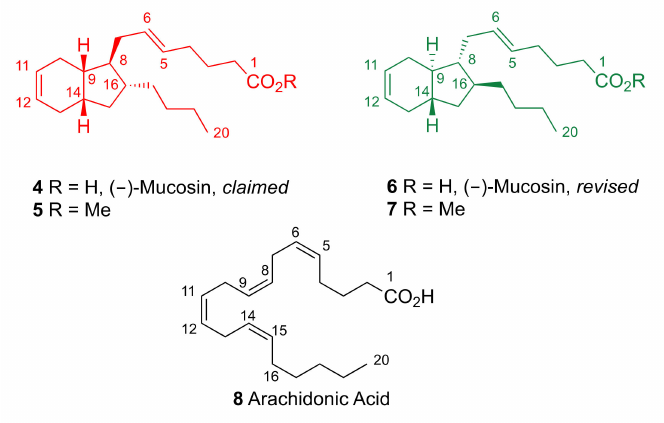
Figure 2. Claimed and revised structures of ( − )-mucosin and relationship to arachidonic